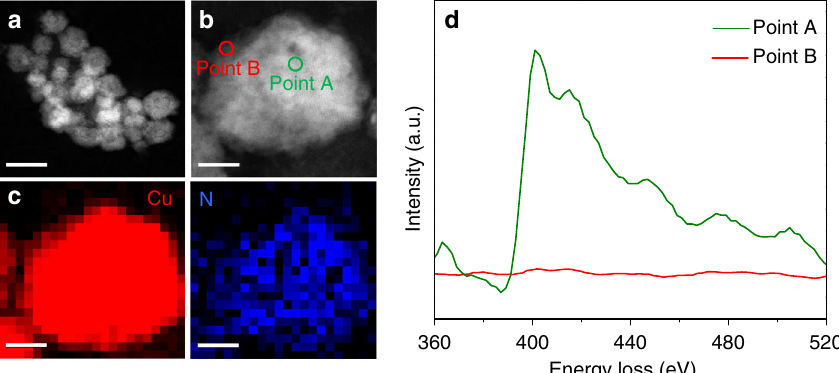
Fig. 2 TEM characterization of the Cu-on-Cu 3 N catalyst. a , b HADDF-STEM images. c STEM-EELS Cu and N Element mapping of one individual particle in b , d , EEL spectra of element N K-edge circled as point A and point B in b . The scale bars are 50 nm in a , and 10 nm in b and